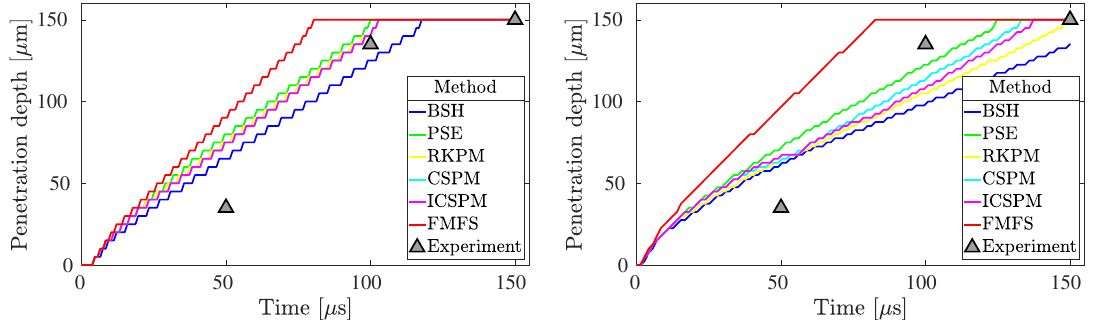
Figure 7. Penetration depth of the laser in time, computed with a total of 27k (left) and 203k (right) particles. Experimental data points in these plots were read from